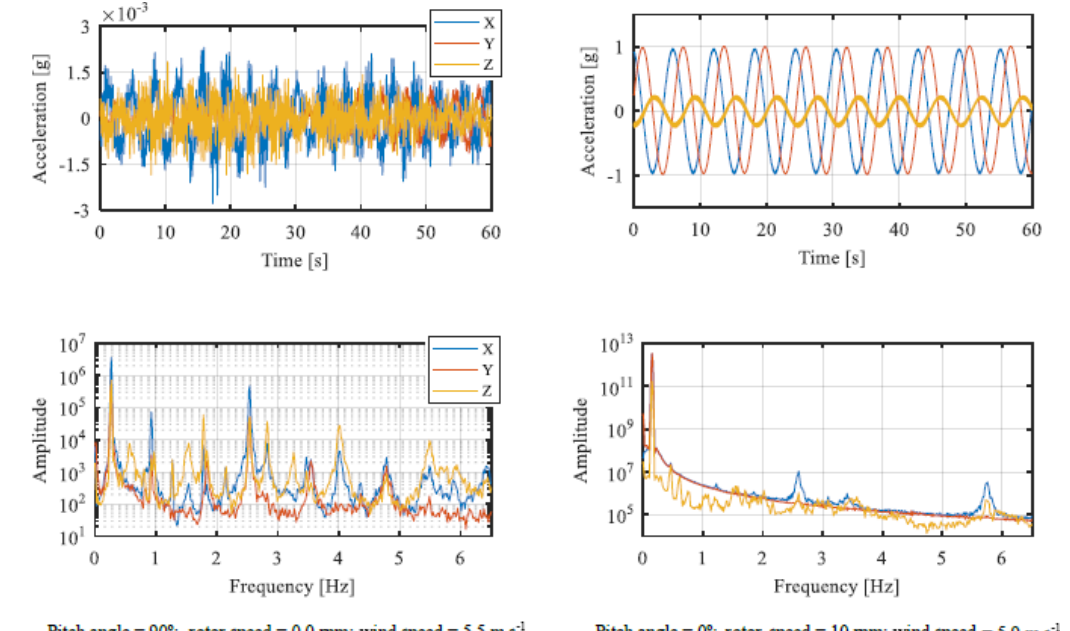
Figure 16. Example of acceleration time series, corresponding operation parameters and power